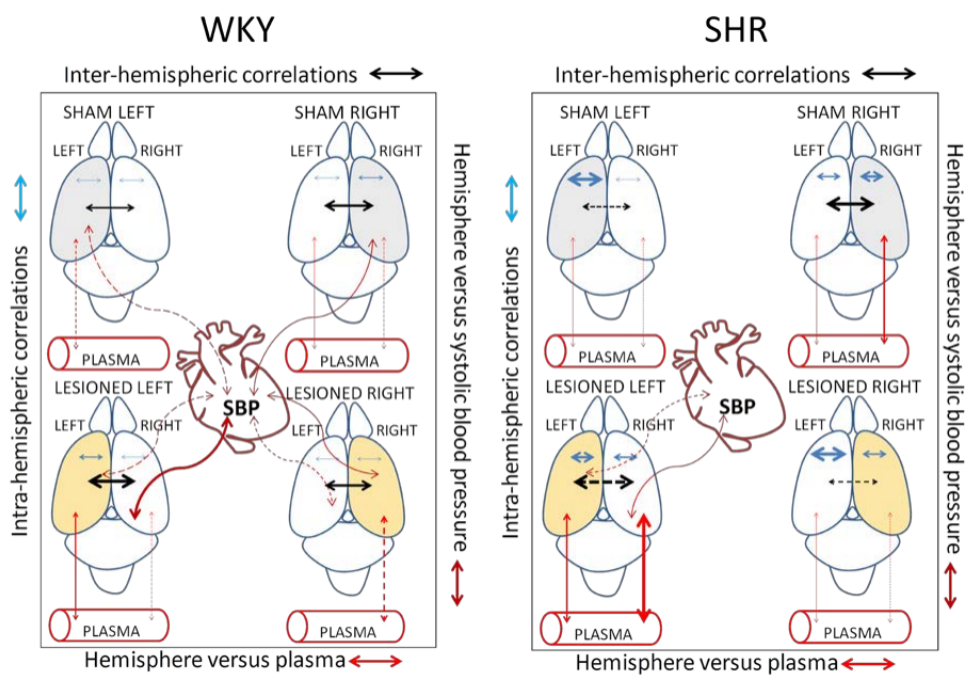
Figure 8. Schematic comparison of the main correlations in WKY and SHR. Intra-hemispheric correlations: blue arrows. Inter-hemispheric correlations: black arrows. Left or right hemisphere versus systolic blood pressure correlations: dark orange. Left or right hemisphere versus plasma correlations: red arrows. Continuous lines: positive correlations. Dotted lines: negative correlations. The thickness of lines is proportional to the number of correlations and the degree of significance.